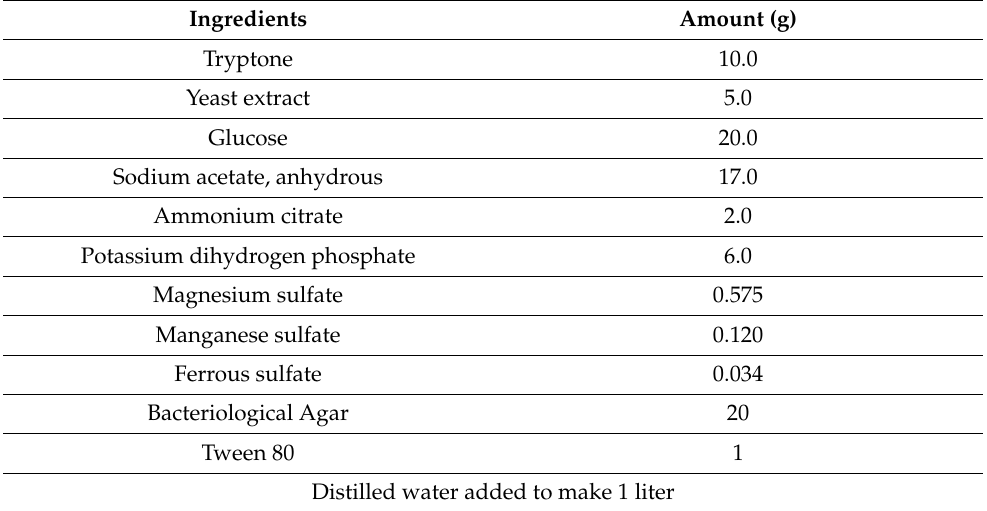
Table 3. Composition of Rogosa